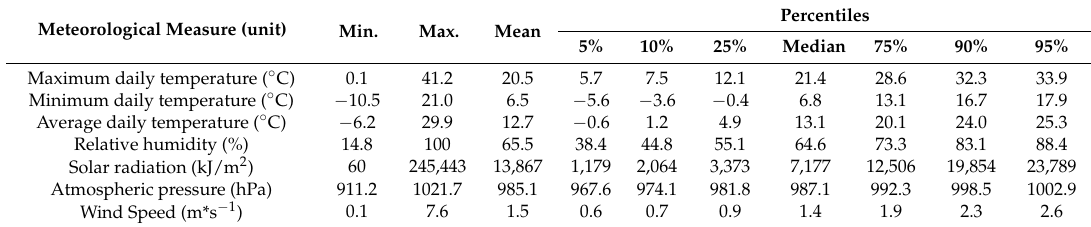
Table 5. Main meteorological indices regarding the assessed time period, broken down by percentiles. Meteorological Measure (unit) Min. Maximum daily temperature ( ◦ C)